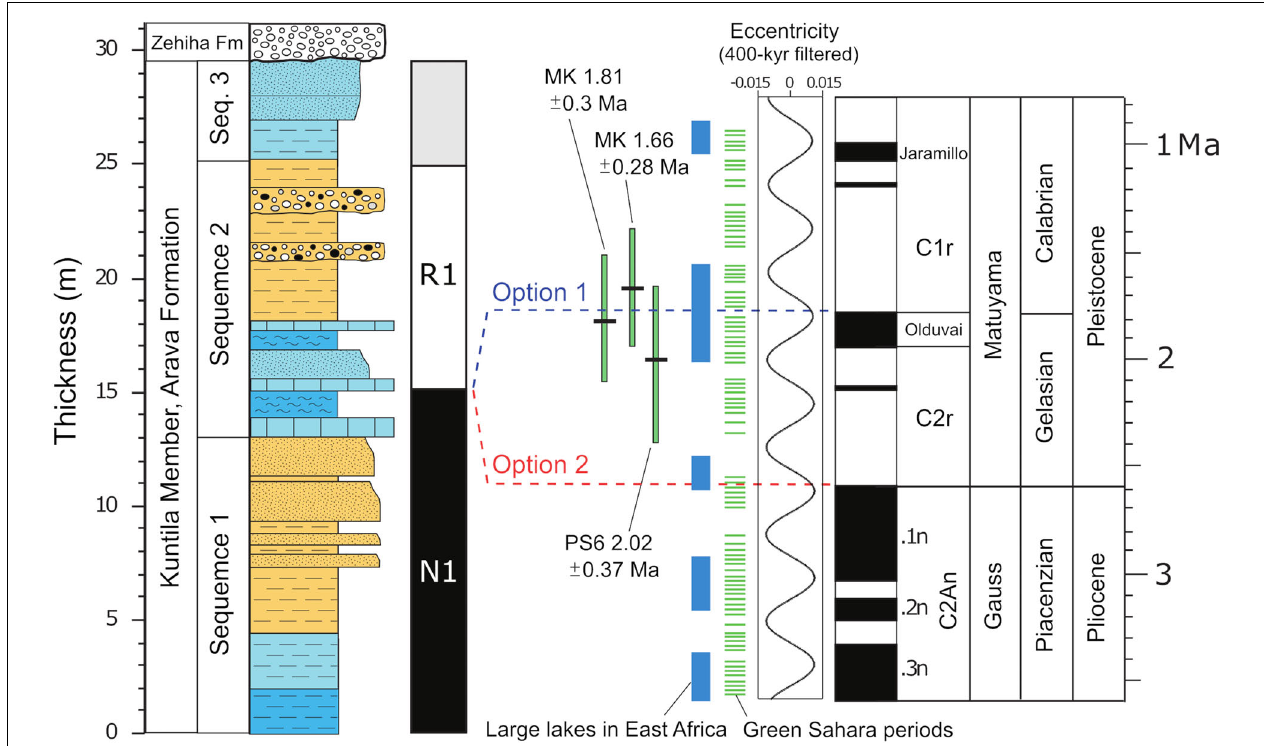
FIGURE 7 | Possible correlations of the Kuntila Lake sediments magnetostratigraphy with the astronomically-tuned Neogene times scale (ATNTS2012, Hilgen et al., 2012) taking into account the 10 Be exposure ages available for the top of the Arava Formation (after Guralnik et al., 2010; Amit et al., 2011). The 400-kyr band-pass filter of eccentricity (Laskar et al., 2004) is shown along with the inferred periods of large lake expansion in East Africa (Trauth et al., 2009) and clusters of Green Sahara periods (Larrasoaña et al., 2013).